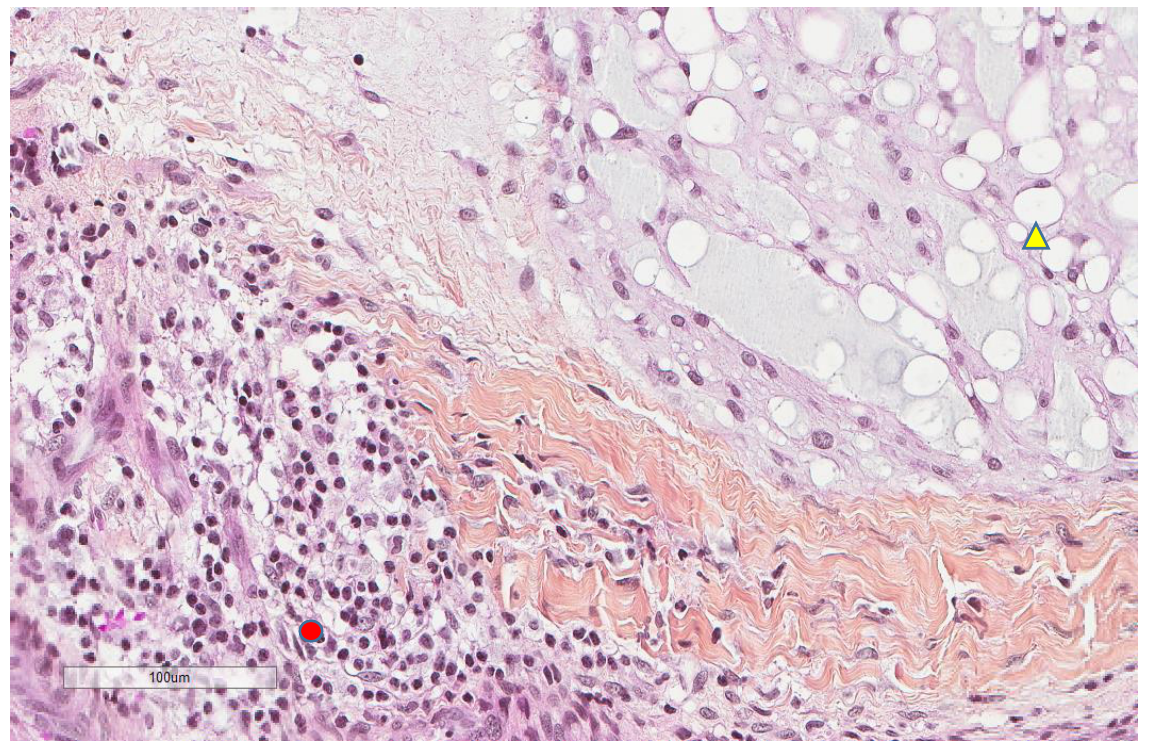
Figure 10. The morphologic features of the same focus previously shown (×200): immune cells (red circle) and tumor cells (yellow triangle).